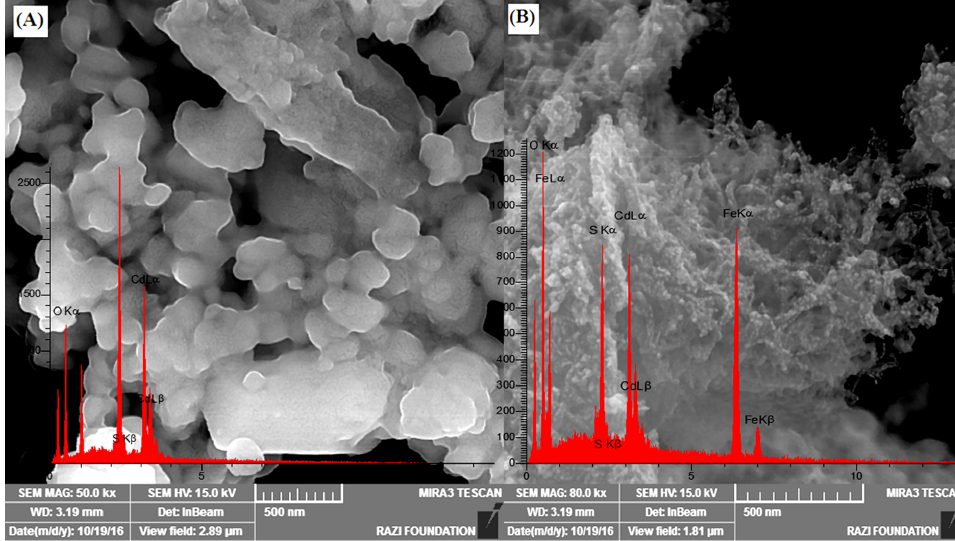
Figure 2. FESEM images and elemental EDX spectra of ( A ) CdS nanoparticles and ( B ) Fe 3 O 4 @MWCNTs- CdS nanocomposite.